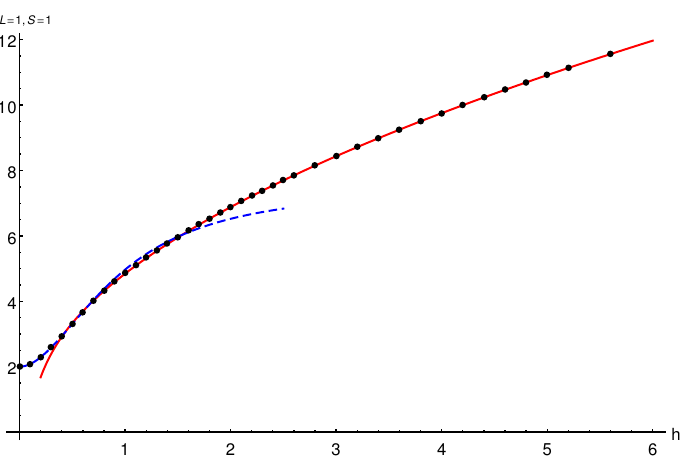
Figure 5 . Plot of (cid:1) L =1 ;S =1 ( h ): the dots correspond to the numerical data reported in table 6 of appendix D.1, while the solid line and the dashed line represent the strong coupling expansion (4.9) and the weak coupling Pad(cid:19)e approximant (4.11) respectively.